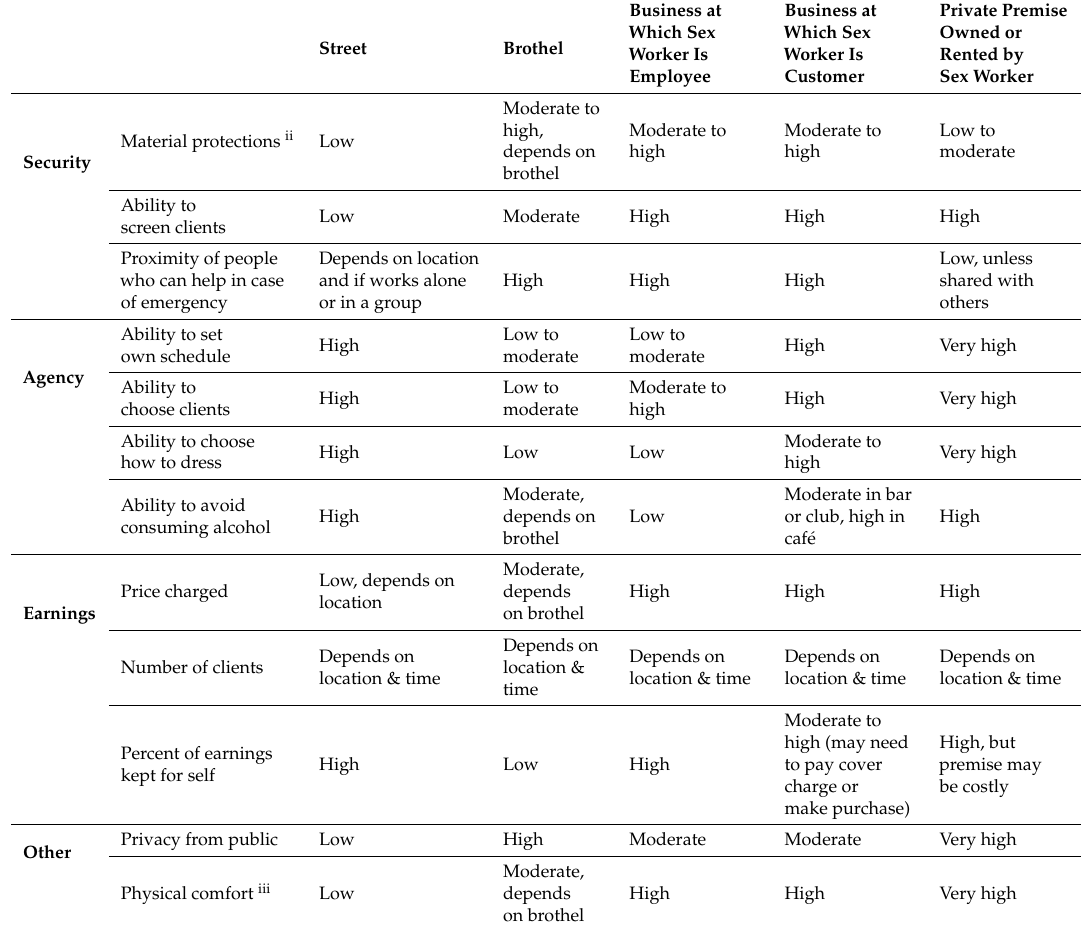
Table A9. Levels of security, agency, earnings, and other conditions in different sex work spaces. i